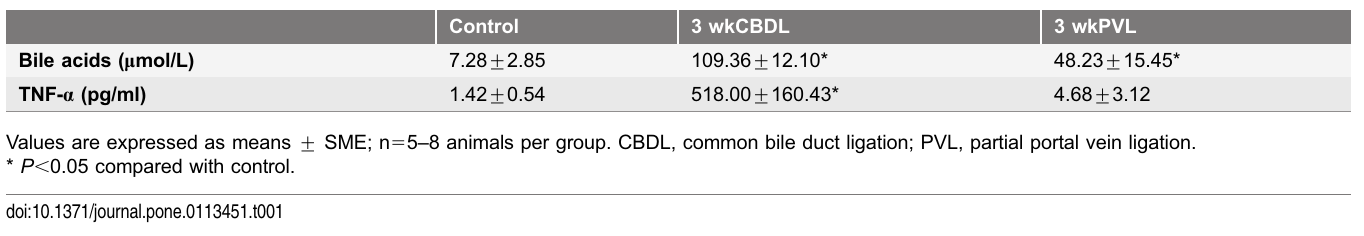
Table 1. Circulating bile acids and TNF- a levels in CBDL and PVL